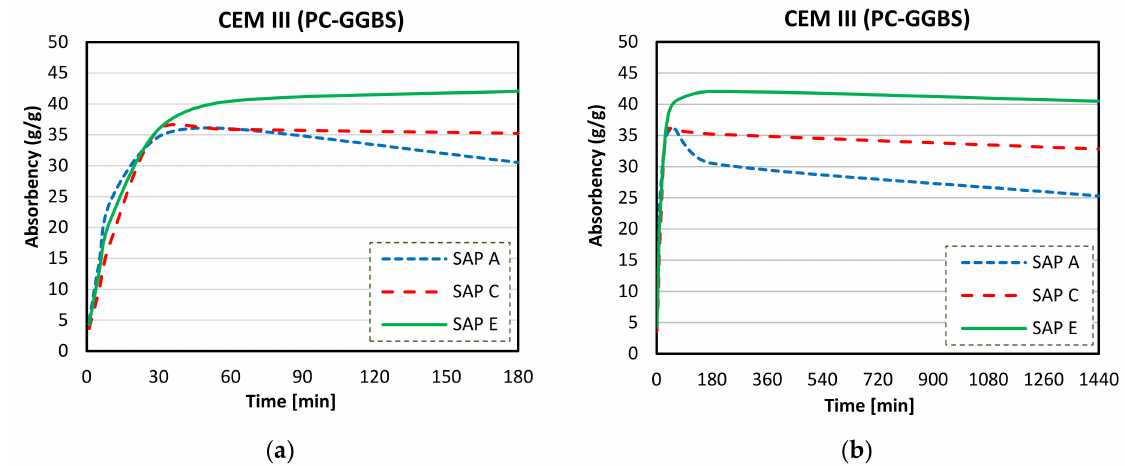
Figure 15. Sorption behaviour of SAPs in CEM III (PC-GGBS) up to 180 min ( a ) and up to 1440 min ( b